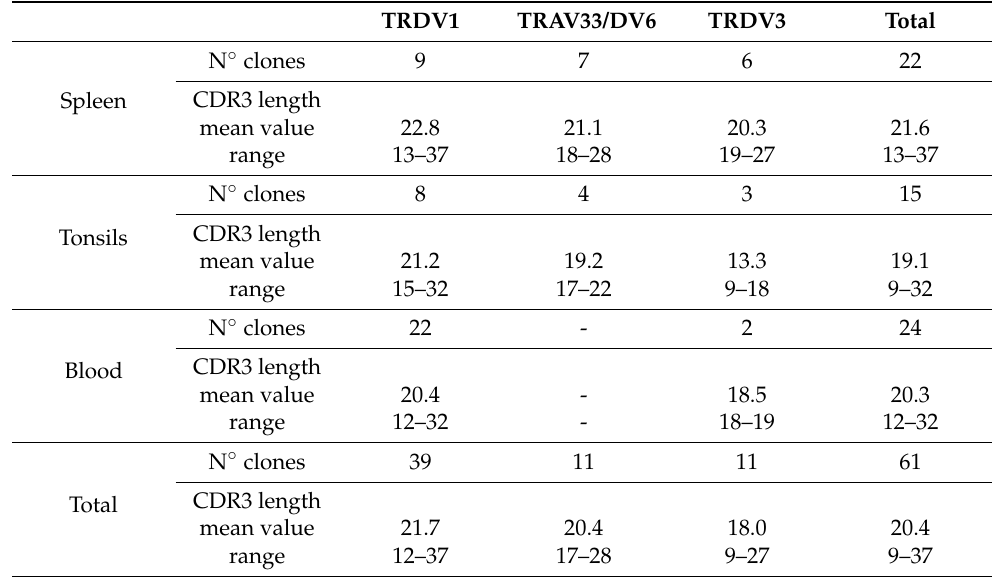
Table 3. CDR3 length (AA) of the cDNAs.